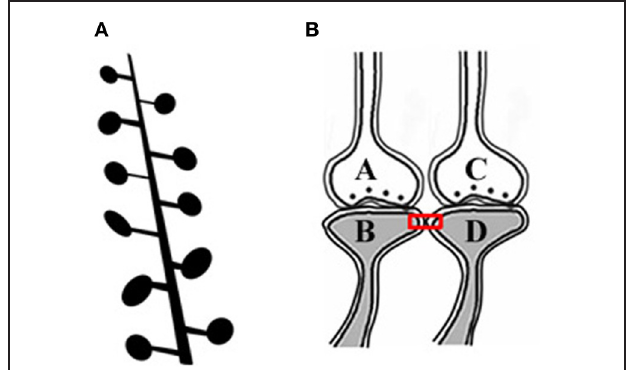
FIGURE 1 | Adjacent dendritic spines and inter-spine space. (A) Cartoon showing dendritic spines (postsynaptic membranes) on a dendritic branch of a neuron typically seen by Golgi staining. Presynaptic terminals are not made visible by Golgi staining. Note that the inter-spine distances are larger than the spine head diameter (Konur et al., 2003). The space between the dendritic spines is occupied by extracellular matrix space, glial cells, axonal (presynaptic), and dendritic (postsynaptic) terminals. (B) Closely located postsynaptic membranes that are simultaneously activated both during associative learning and LTP induction. A functional LINK (shown by the red rectangular box) is expected to form between the postsynapses as a function of the simultaneous arrival of activity at these postsynapses. A and C are presynapses and B and D are their corresponding